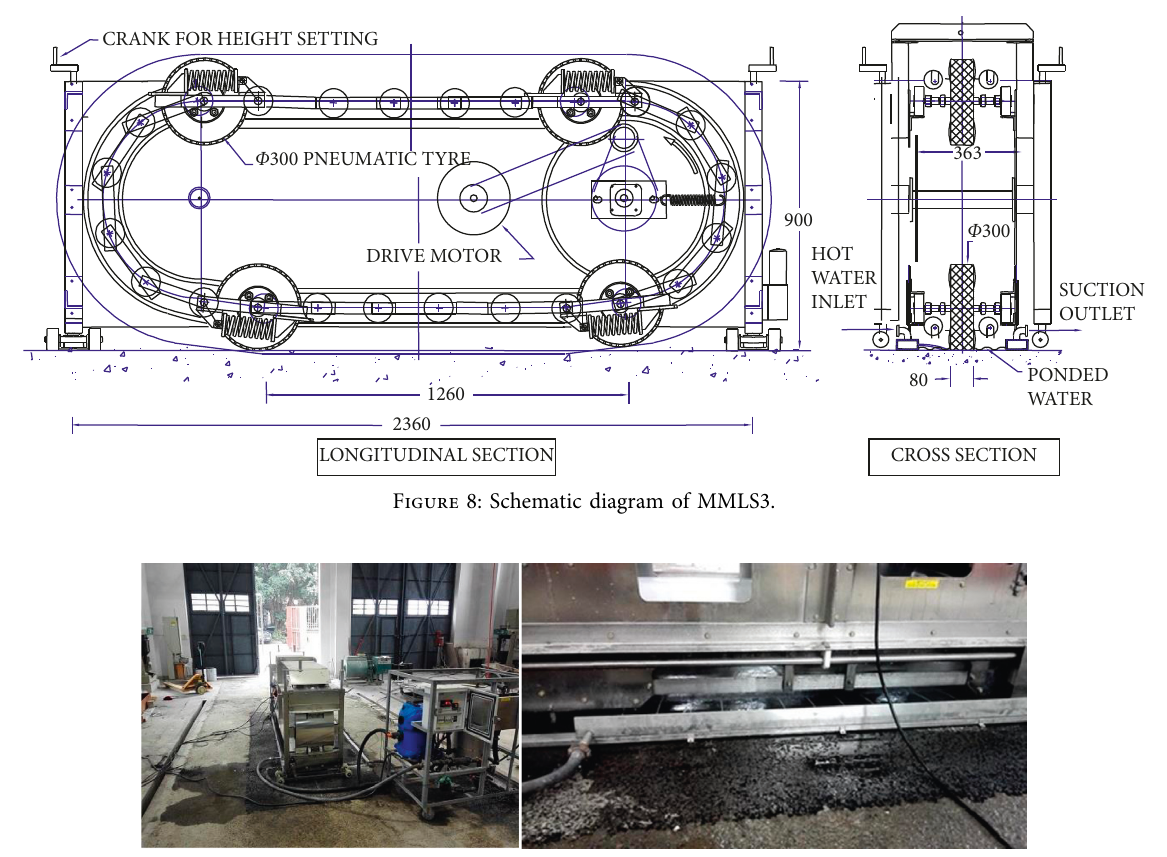
Figure 9: MMLS3 and water heater unit.